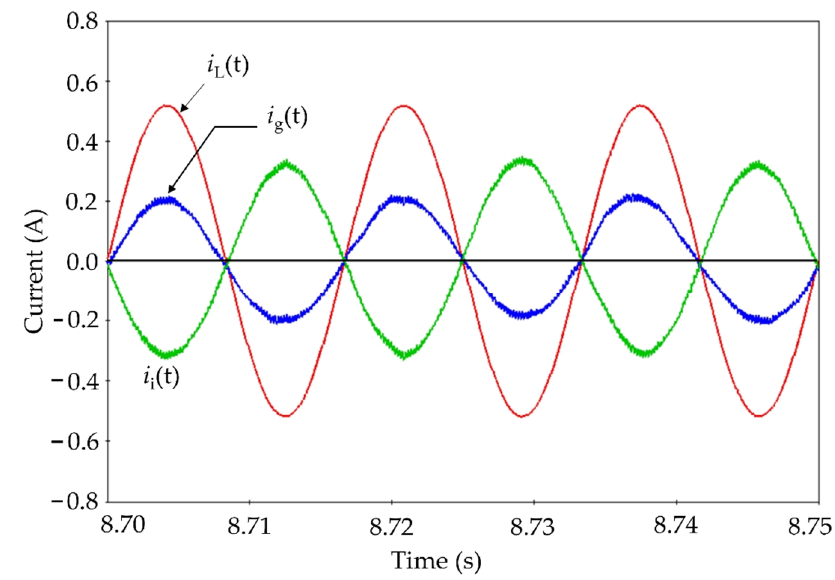
Figure 11. Simulation result of PQ control case.